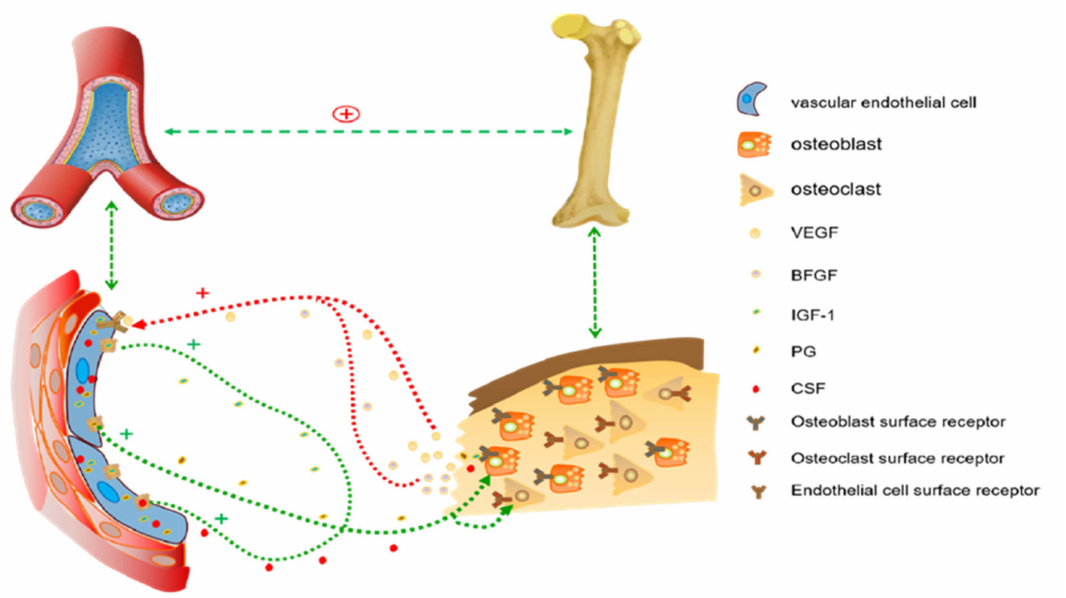
Figure 6. The schematic diagram shows the relationship between vascularization and